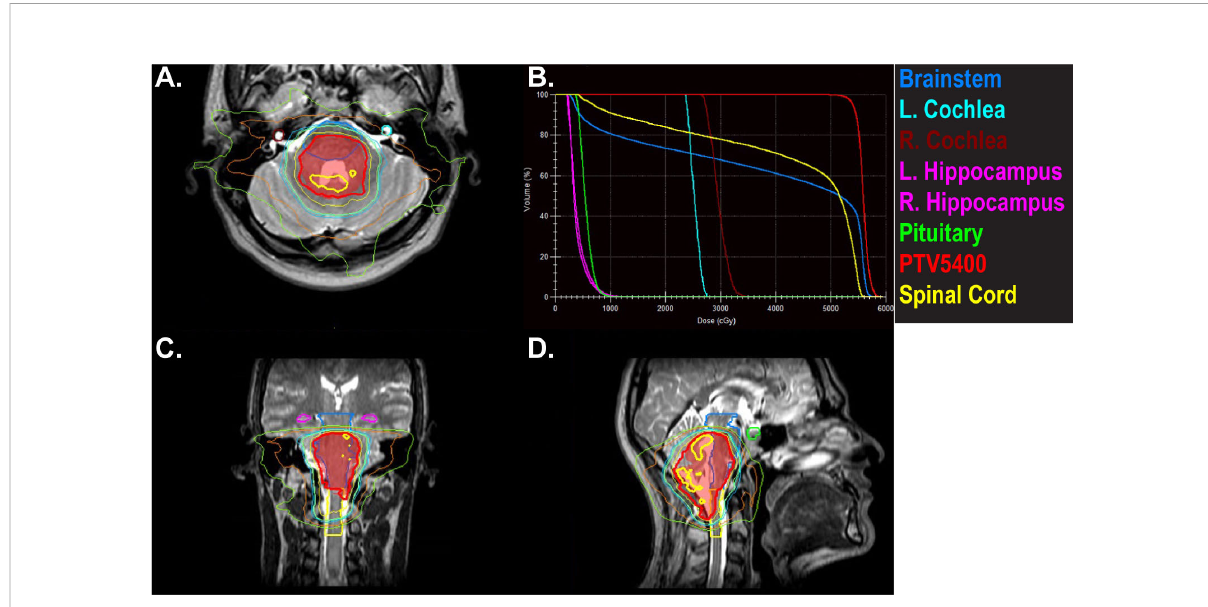
FIGURE 4 A 22-year-old male with posterior fossa ependymoma underwent near total resection and adjuvant radiotherapy to 54 Gy followed by a cone down boost to 59.4 Gy. Panels (A, C, D) depict the initial plan to 54 Gy. The hot spots of 57 Gy (thick yellow line) are kept off the brainstem andspinal cord. The PTV is in red color wash. Panel (B) shows doses to organs at risk that were prioritized during the treatment planning process and during daily adapt-to-shape